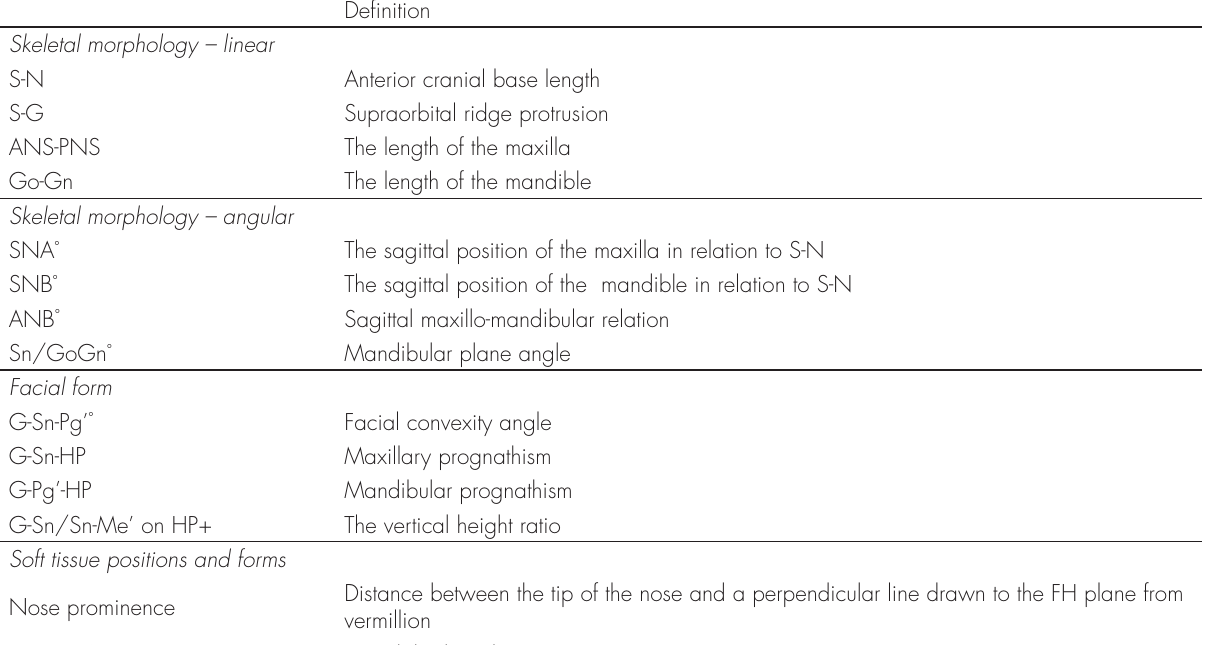
Table I. Definitions of linear and angular measurements made on lateral